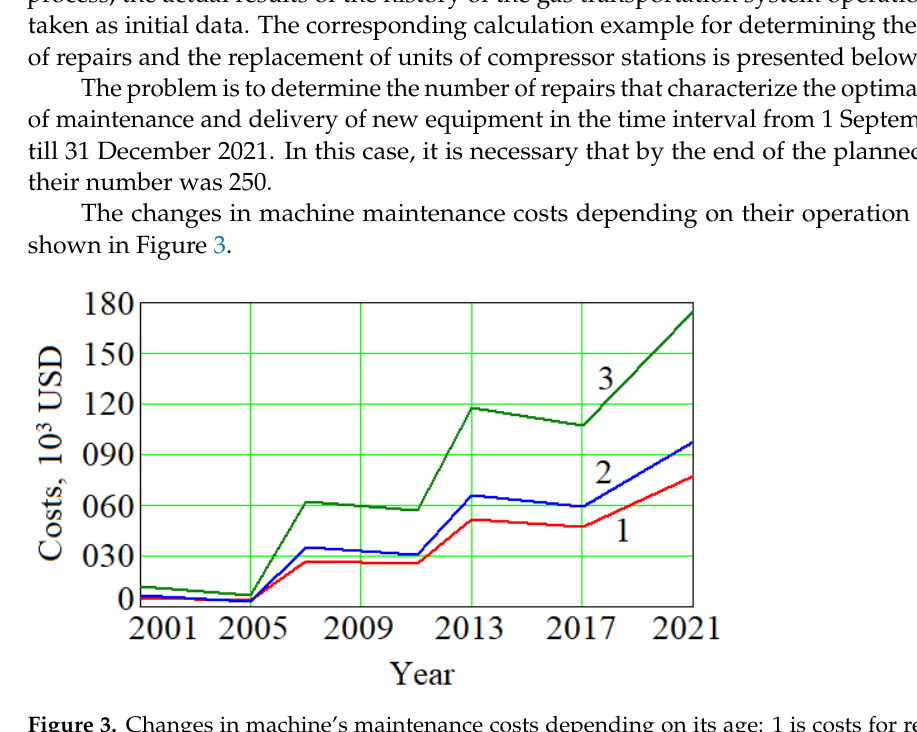
Figure 3. Changes in machine’s maintenance costs depending on its age: 1 is costs for repair; 2 is costs for exploitation; 3 is total costs.